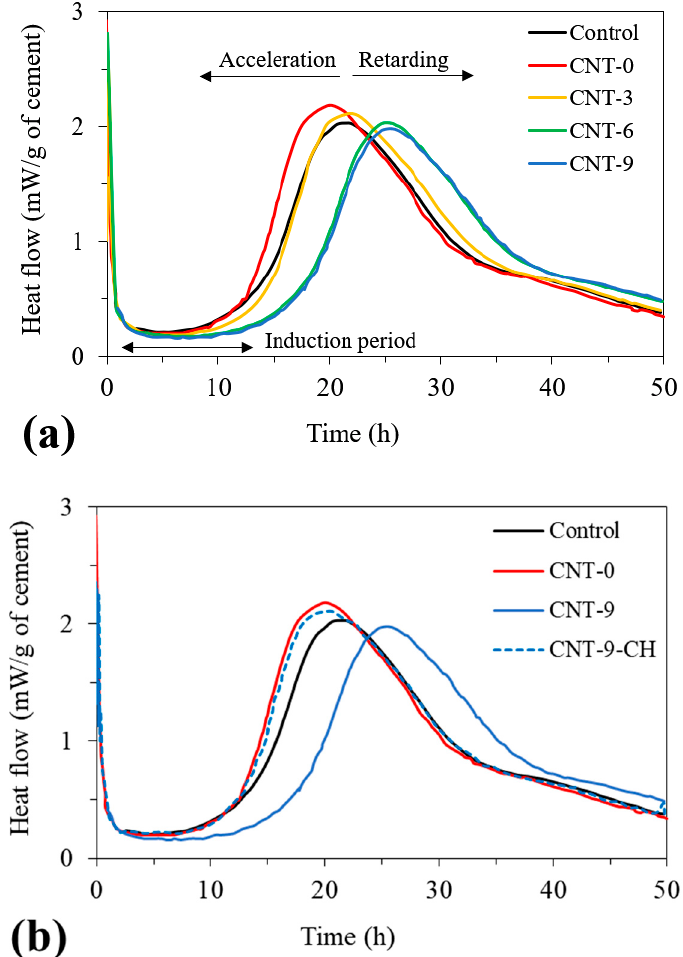
Figure 4. Isothermal calorimetry curves of the cement pates. ( a ) CNT with different exposure times Table 2. SO 4 /HNO 3 . ( b ) CNT with and without subsequent Ca(OH) 2 neutralization.